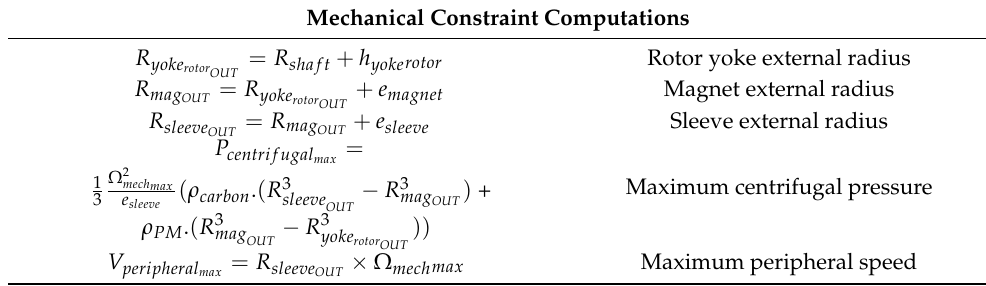
Table 5. Sleeve mechanical